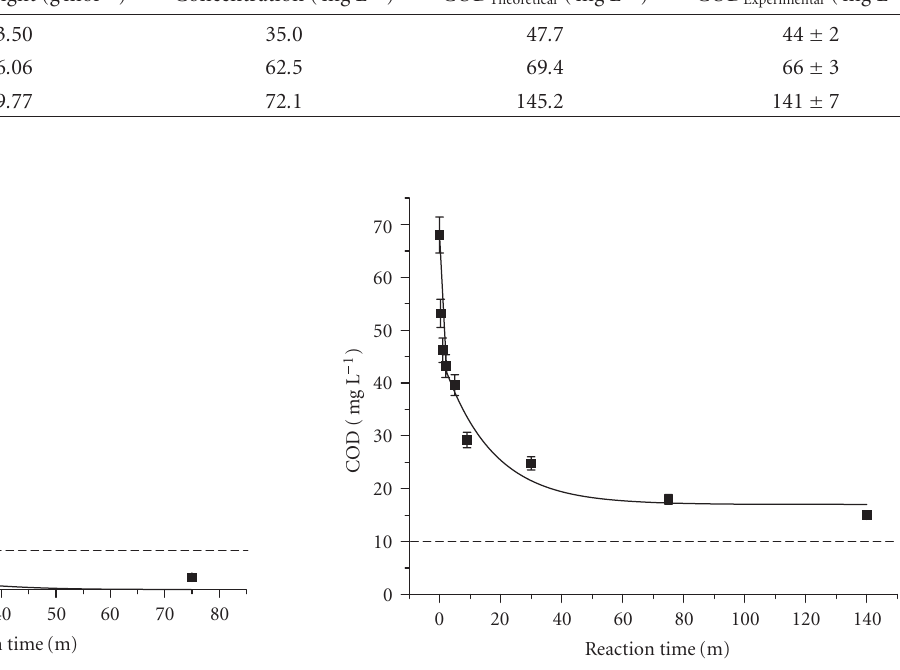
Table 2: Showing the theoretical and experimental COD values for the aqueous solutions of chlorbromuron, atrazine, and alachlor. Herbicide name